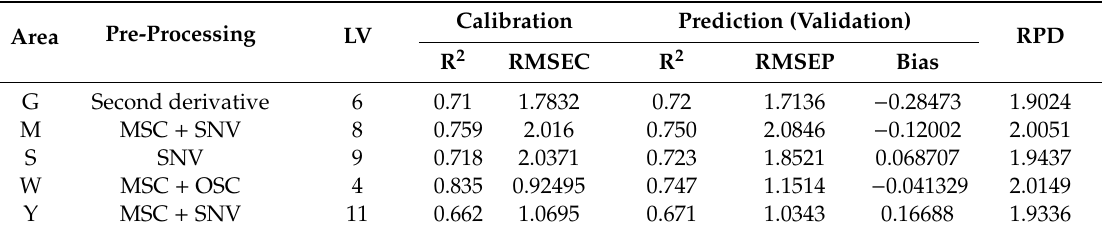
Table 6. Best results of each area with second derivative data and their preprocessing at a spectral sampling range of 729–975 nm using partial least square regression (PLSR).